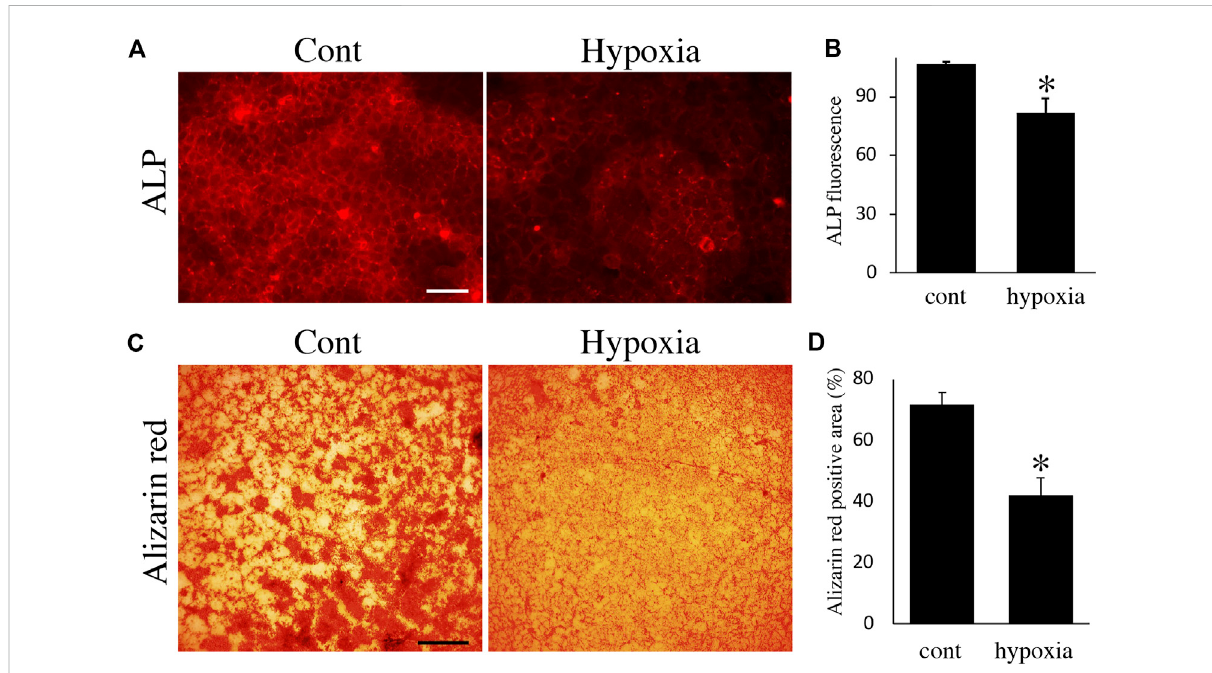
FIGURE 7 The effect of oxygen-mediated energy metabolic shift on mineralization. (A) ALP staining of HAT7 cells cultured in normoxia (left) and hypoxia (right) for 48 h. (B) Quanti fi cation of ALP fl uorescence; n = 3. (C) Alizarin red staining of HAT7 cells cultured in normoxia (left) and hypoxia (right) for 7 days. (D) Image analysis of the mineral coverage (Alizarin red positive) in the culture dish; n = 3. Data are represented as their mean ± SD. * p < 0.05 (unpaired two-tailed Student ’ s t -test). Scale bars, 50 μ m (A) ; 500 μ m (C)